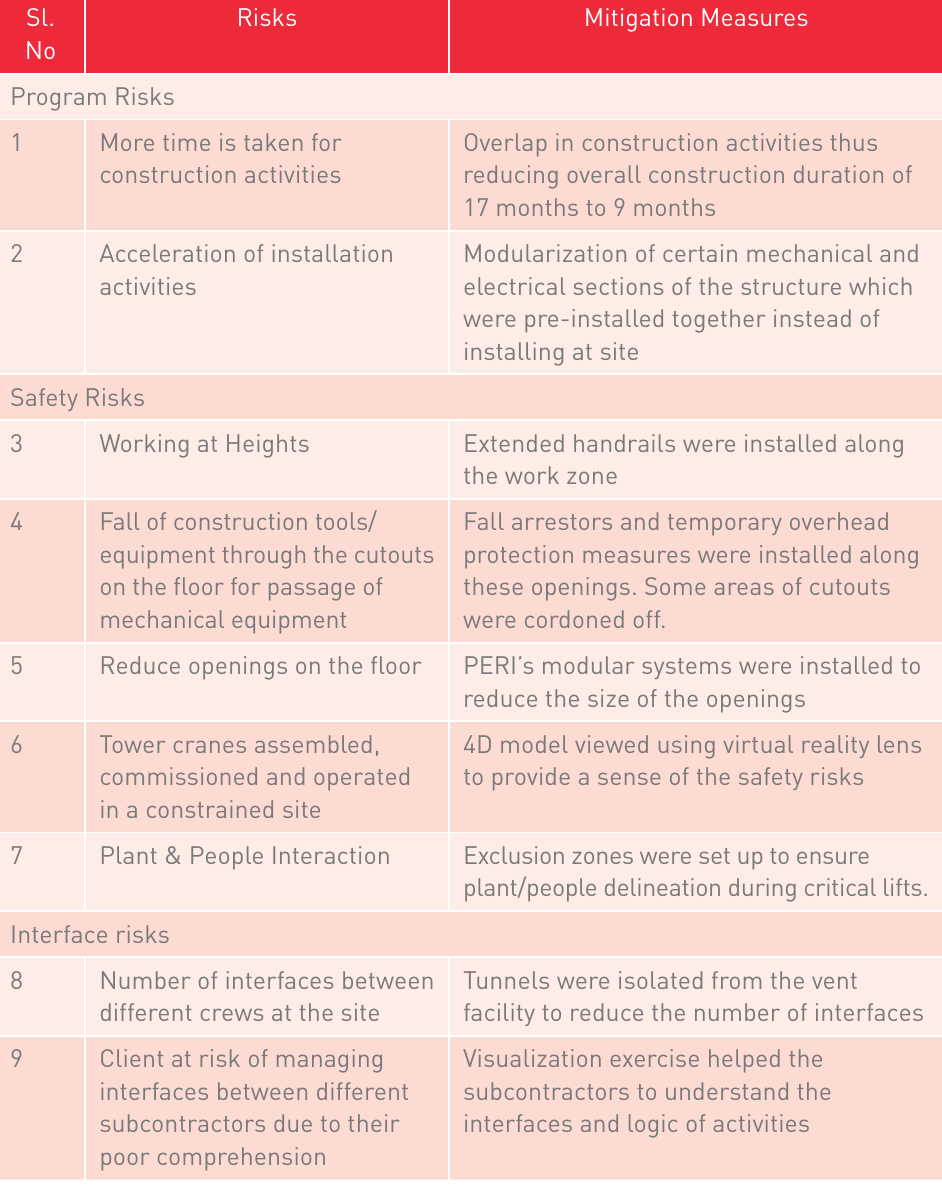
Risks and mitigation measures observed from the case